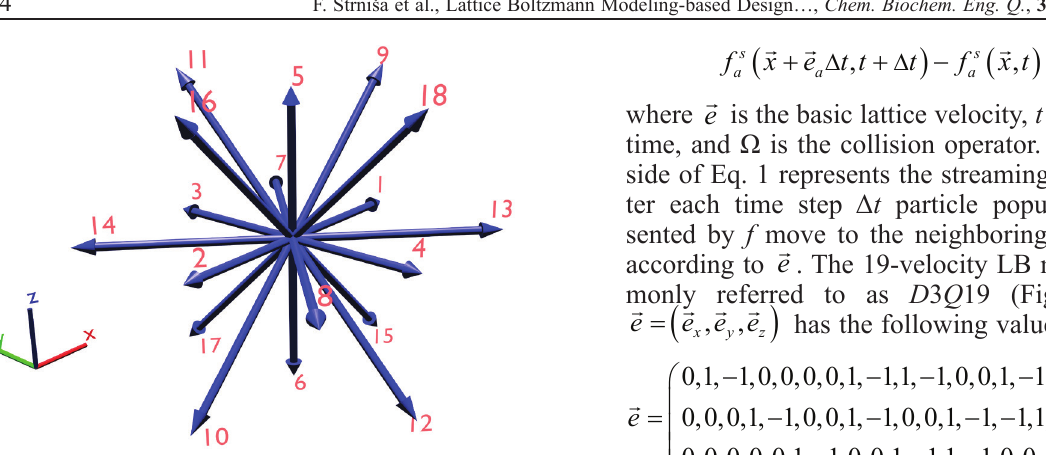
Fig. 1 – Graphic representation of the D3Q19 velocity-set. The image is showing the basic lattice velocity vectors numbers 1 to 18 representing the index a · ( ) pictured